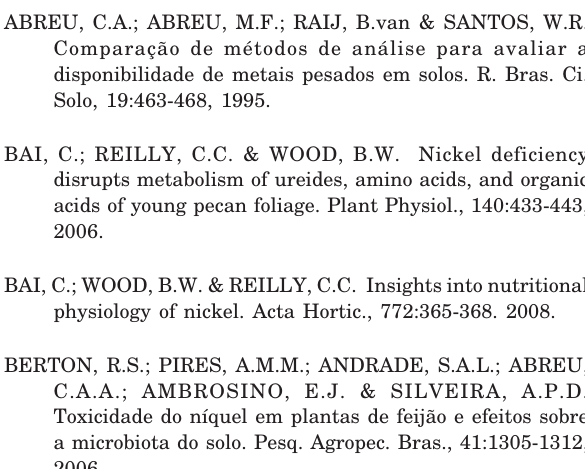
Significant at 5 % based on a t -test.